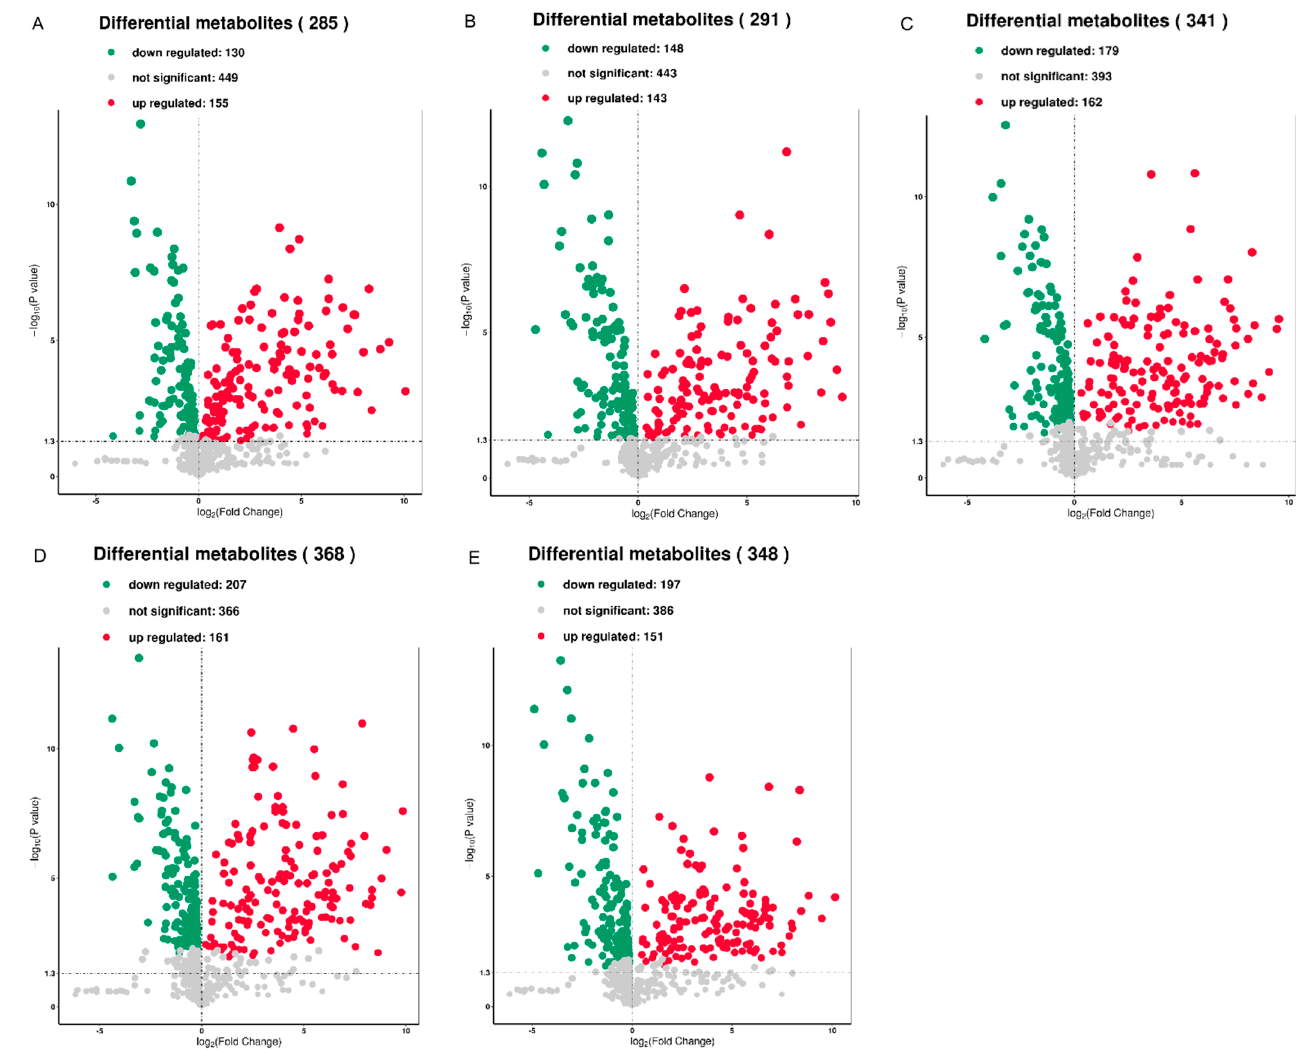
Figure 4. Different metabolites in the grains after different hyphal development stages of Tilletia laevis infection. ( A ) Volcano plots of different metabolites in the suspension of teliospores (T1) and the control (CK) group. ( B ) Volcano plots of different metabolites in the promycelia (T2) and control (CK) group. ( C ) Volcano plots of different metabolites in the primary basidiospores (T3) and control (CK) group. ( D ) Volcano plots of different metabolites in the H-bodies (T4) and control (CK) group. ( E ) Volcano plots of different metabolites in the secondary basidiospores (T5) and control (CK) group.